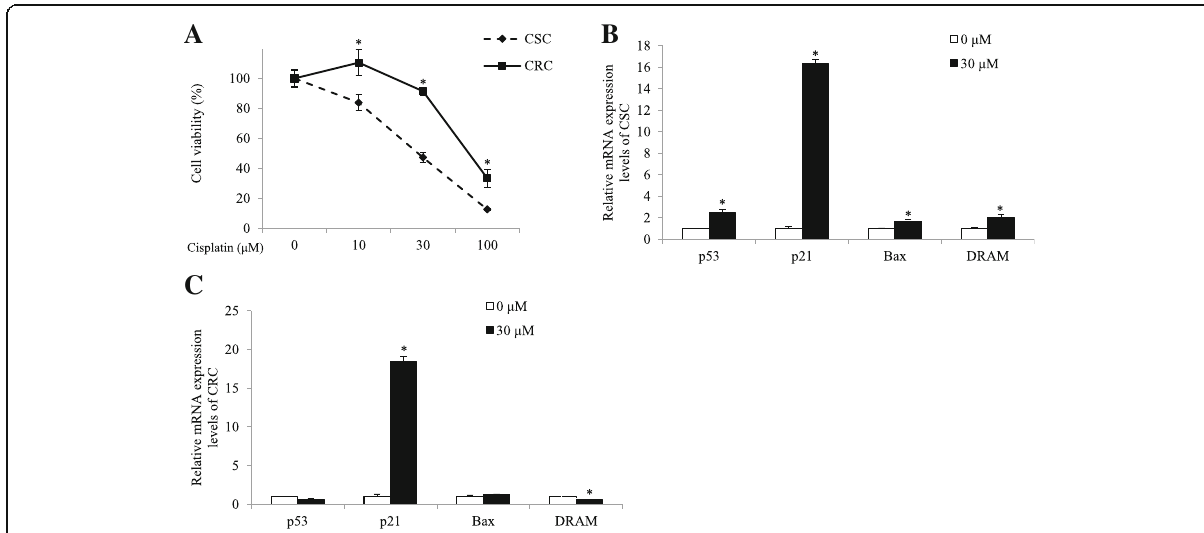
Fig. 1 Effects of cisplatin on the cell viability and mRNA expression levels of p53 , p21 , Bax , and DRAM in CSC and CRC. Cells were exposed 10 ~ 100 μ M of cisplatin for 24 h. a Cell viability according to cisplatin treatment in CSC and CRC was measured by MTT assay. After cells were exposed 30 μ M of cisplatin for 24 h, mRNA expression levels of ( b ). p53 , p21 , Bax , and DRAM in CSC and ( c ). p53 , p21 , Bax , and DRAM in CRC were quantified by qPCR. All mRNA expression levels were normalized against TBP . Each value is the mean ± SD. p < 0.05 was taken to define statistical significance. Two tailed Student ’ s t-test and one-way ANOVA followed by Duncan post hoc